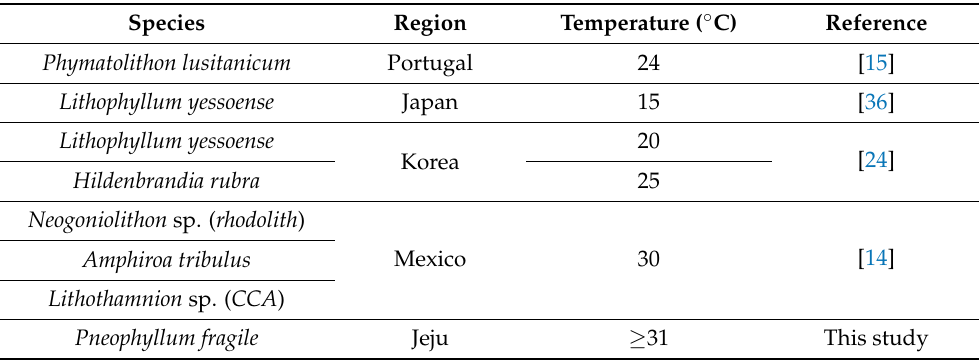
Table 2. Photosynthesis rate, saturation irradiance, and optimal temperature measured for selected coralline algae from different regions. The values were normalized to mmol O 2 m − 2 h − 1 for compari- son. E k is given in µ mol photons m − 2 s − 1